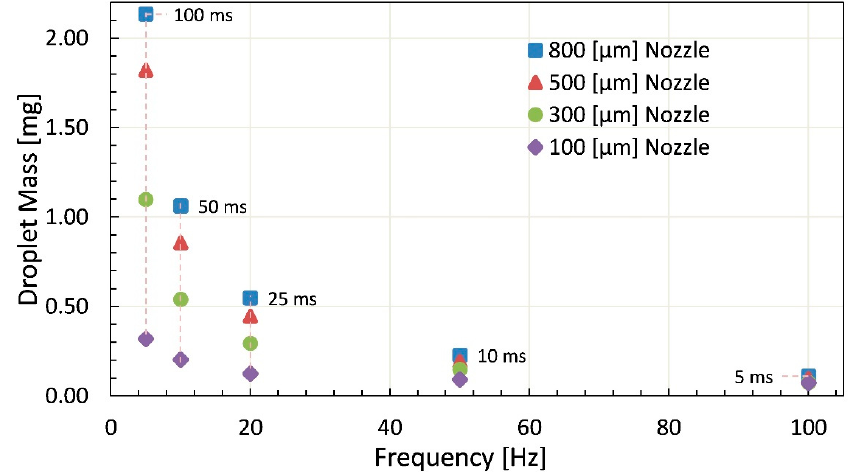
Figure 13. Droplet mass of dispensed droplets using 12,480 mPa · s liquid silicone by Brookfield plotted against frequency with respect to varying open time and nozzle diameter.